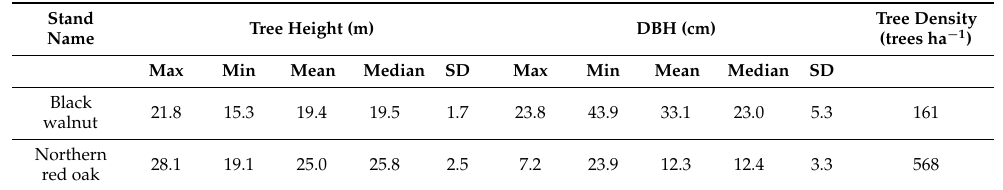
Table 1. Tree height and DBH of the black walnut and northern red oak stands from the field measurements and stand tree